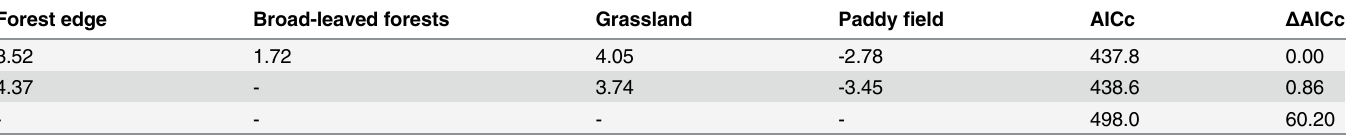
Figures show z values.